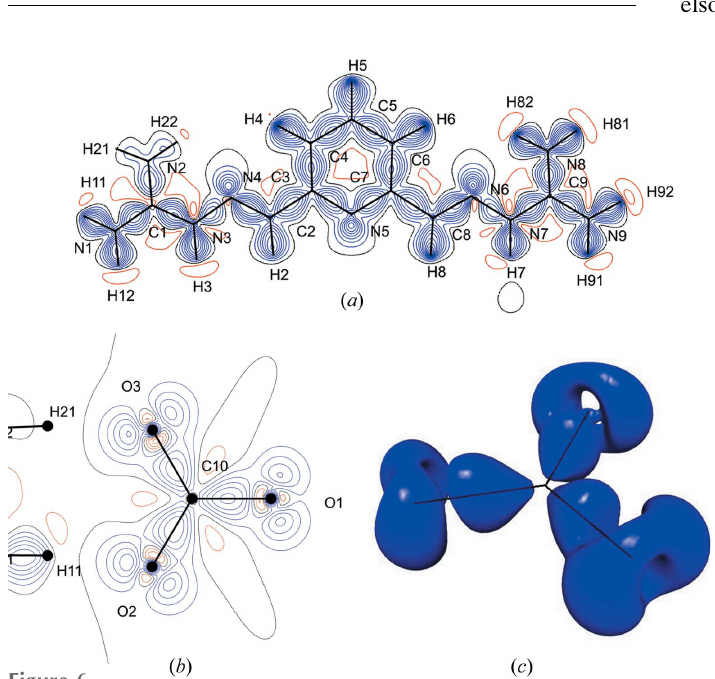
Figure 6 Deformation density ( a ) in the plane of the dication and ( b ) in the plane of the anion. Blue contours are positive density and red ones are negative. The contour level is 0.10 e A˚ (cid:2) 3 . ( c ) The anion deformation density iso-surface at 0.15 e A˚ (cid:2) 3 .